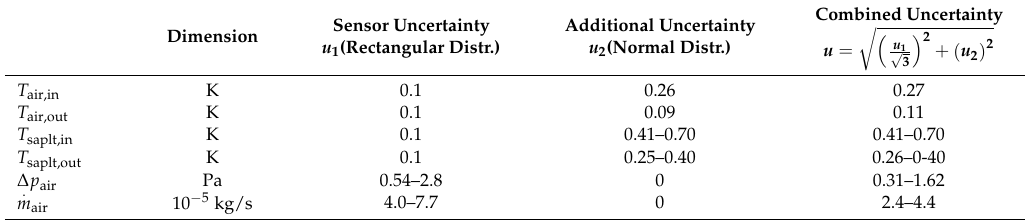
Table 3. Uncertainties of main parameters for pin fin test sample; sensor uncertainties are based on manufacturer information or calibration; additional uncertainties are related to positioning and